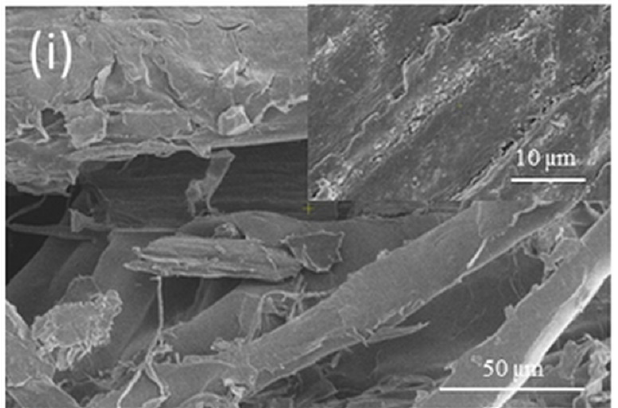
Figure 11. SEM images of ( a ) hemp fibres, ( b ) polypropylene, ( c ) polyester, ( d ) bicomponent fibres; ( e ) 75H25PP, ( f ) 50H50PP, ( g ) 25H75PP, ( h ) 50H50PES and ( i ) 50H50BI.